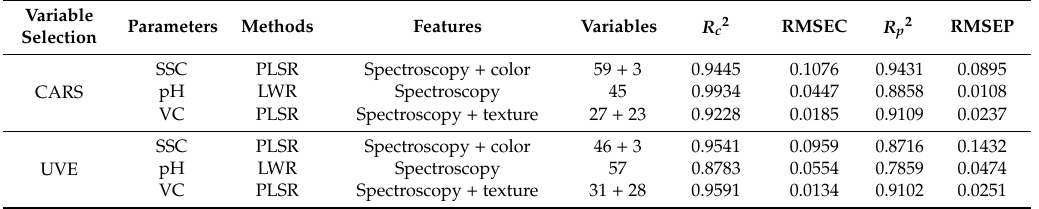
Table 4. Prediction results of SSC, pH, and VC of 120 strawberries using important variables of multiple features. UVE = uninformative variable